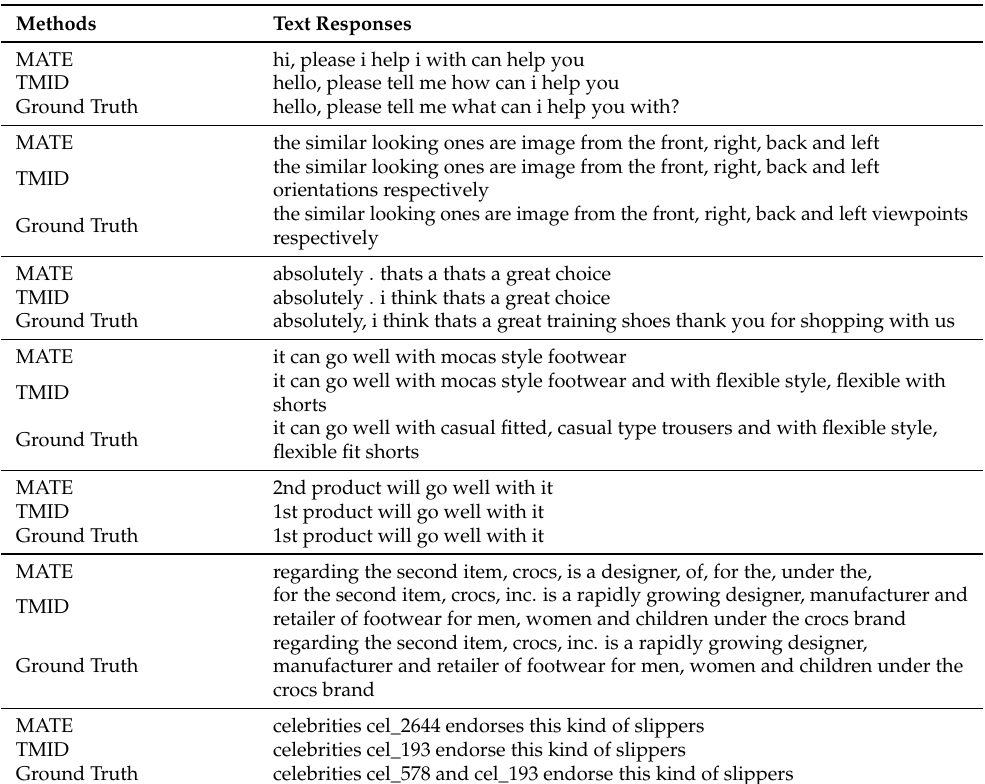
Table 4. Case study of